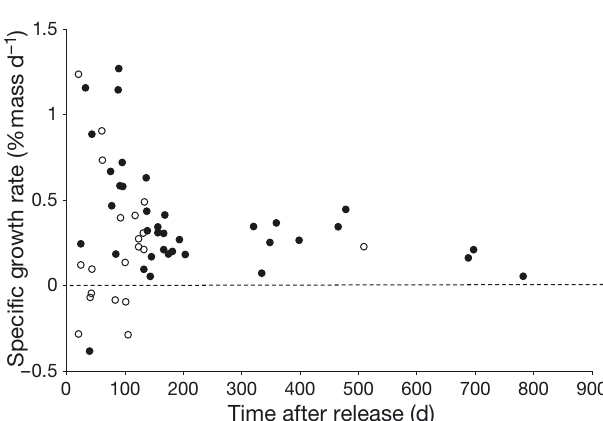
Fig. 6. Oncorhynchus mykiss . Specific growth rate of Floy- tagged rainbow trout released from 2 commercial aquacul- ture operations that were recaptured by angling at the farm sites (open circles) or >500 m away from the farm sites (i.e. dispersed) (solid circles). The dashed line on the y -axis at 0 separates fish with positive (above line) and negative (below line) specific growth